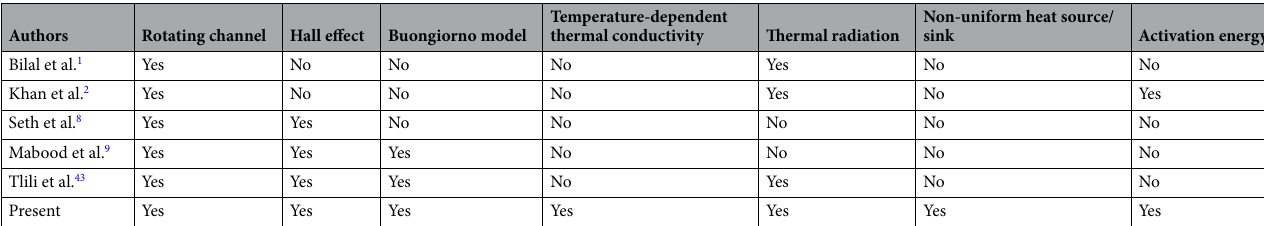
Table 1. An inspection of literature for the innovation of the presented